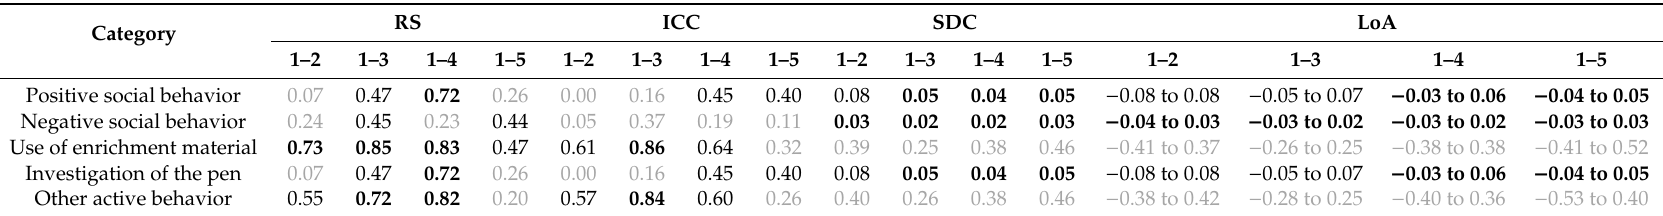
Table 7. Statistical parameters (Spearman’s rank correlation coe ffi cient: RS, intraclass correlation coe ffi cient: ICC, smallest detectable change: SDC, limits of agreement: LoA) for the comparison of the five farm visits (1–5) for the categories of the behavioral observations by instantaneous scan sampling, indicating poor (normal type, gray color), acceptable (normal type, black color), and good (bold type, black color) reliability or agreement,